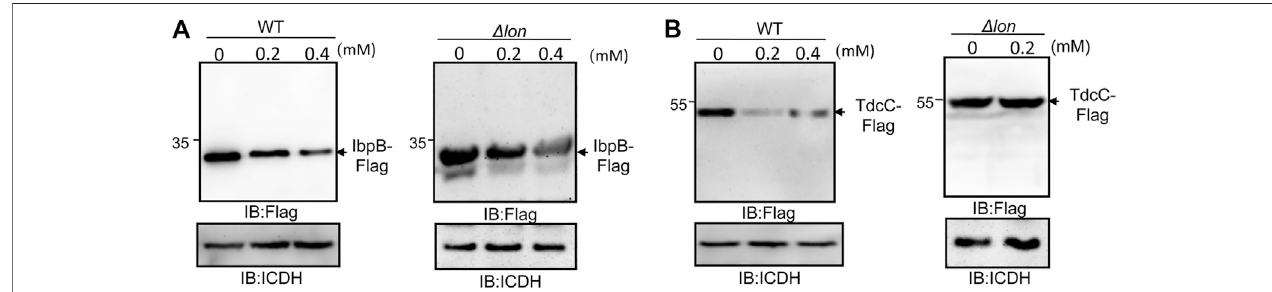
FIGURE5| Thymol-induceddegradationoftwonon-virulenceproteinsrequirestheLonprotease.PlasmidsharboringFlagfusedtotheheatshockproteinIbpB (A) and the threonine/serine transporter TdcC (B) were introduced into wild type S . Typhimurium and its lon mutant, respectively. Thymol was added to the cultures for 4 h prior to the detection of the fusion proteins by immunoblotting with a Flag-speci fi c antibody. The bacterial ICDH was probed and served as a loading control. The experiments were repeated at least three times each with independent biological samples.